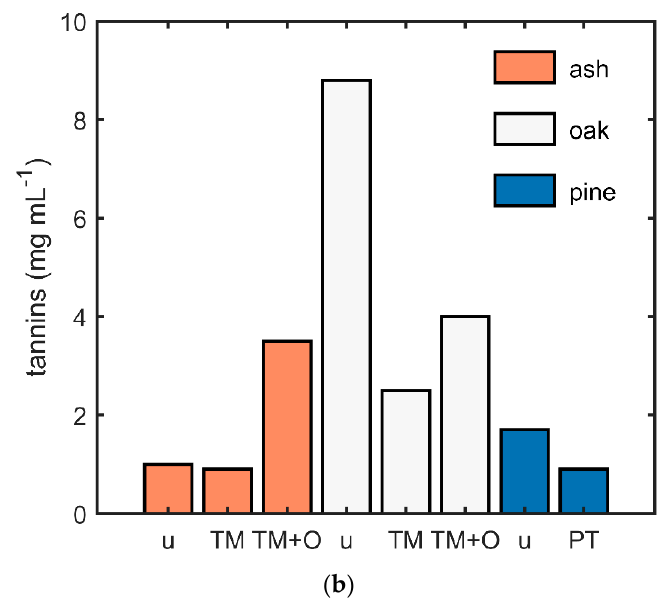
Figure 2. pH ( a ) and concentration of tannins ( b ) found in the different wood treatments. Legend: u = untreated, TM = Thermally Modified, TM + O = Thermally Modified with Oil treatment, PT = Preservative Treatment.